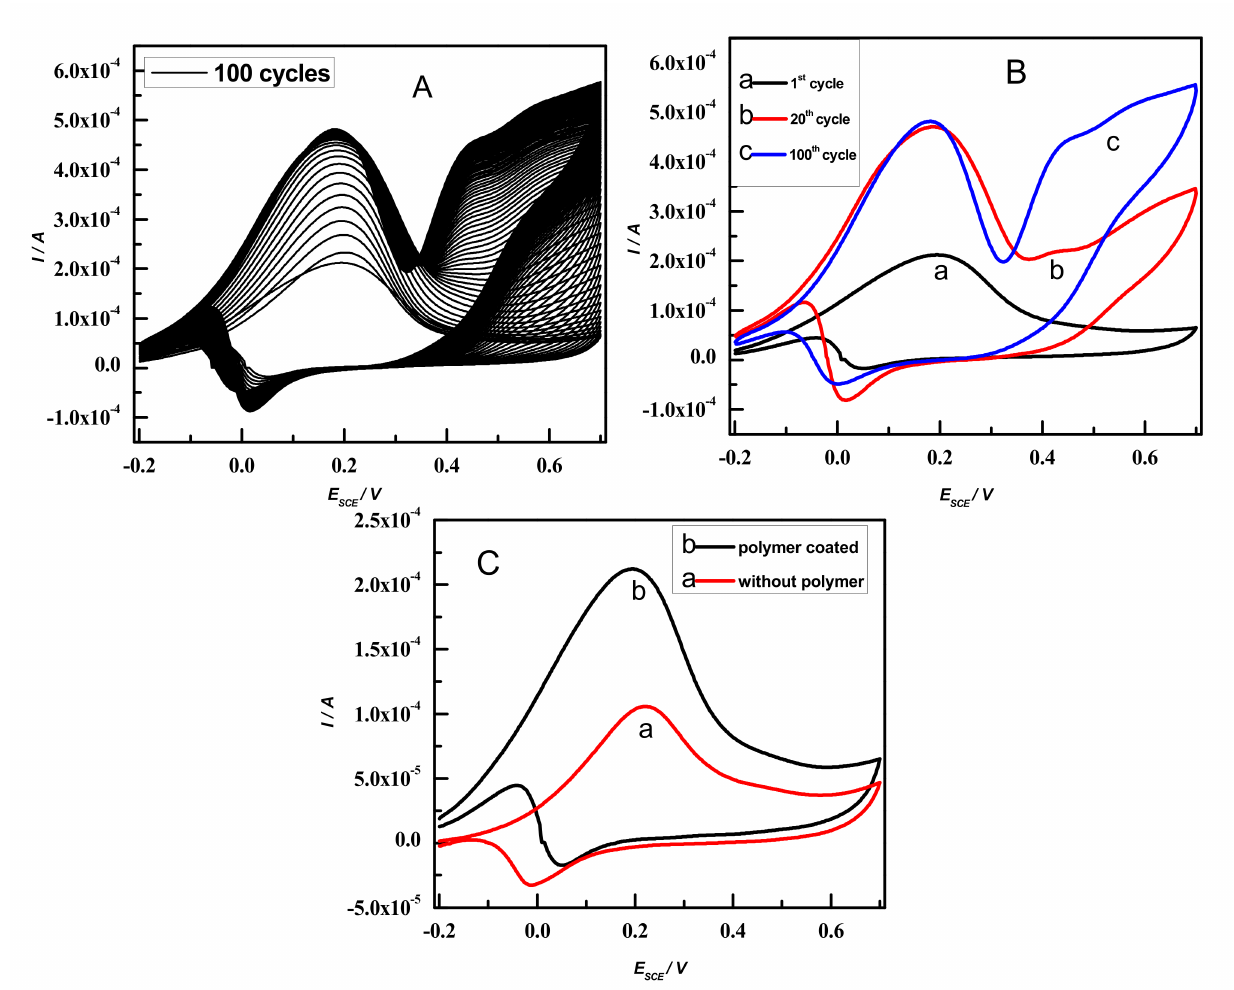
Figure 4. Cyclic voltammograms of PACHA coated gold substrate in 1.8 M NaOH + 5 M CH 3 OH solution at 50 mV/s. ( A ) 100 cycles; ( B ) 1st, 20th, and 100th cycles; ( C ) CV curves of methanol electro oxidation recorded on PACHA coated and uncoated gold